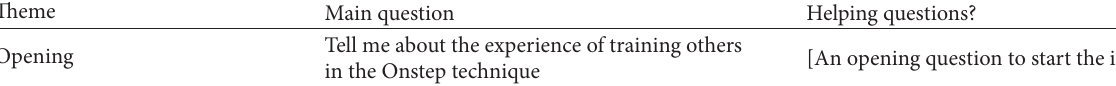
Table 1: Interview